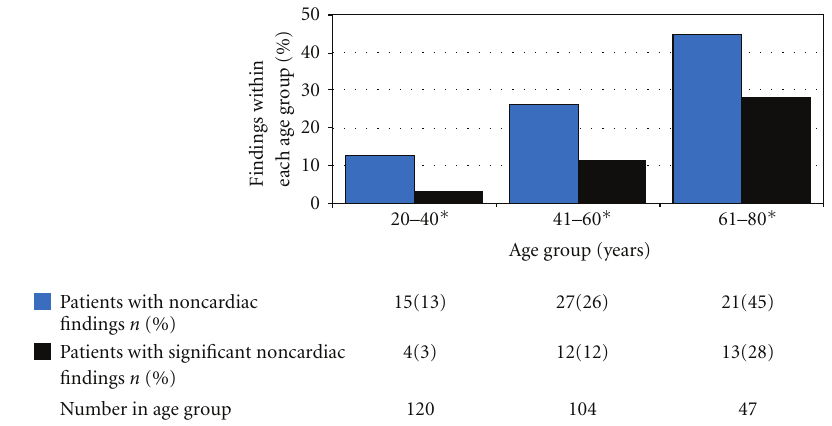
Figure 2: Prevalence of noncardiac findings by age within adult cohort. The di ff erence in the percent of significant noncardiac findings between these age groups was statistically significant ( P < 0 . 05 using the χ 2 test for independence). The age group greater than 80 years of age was comprised of one patient with a noncardiac finding which was not significant. This age group was not included in our analysis due to the small sample